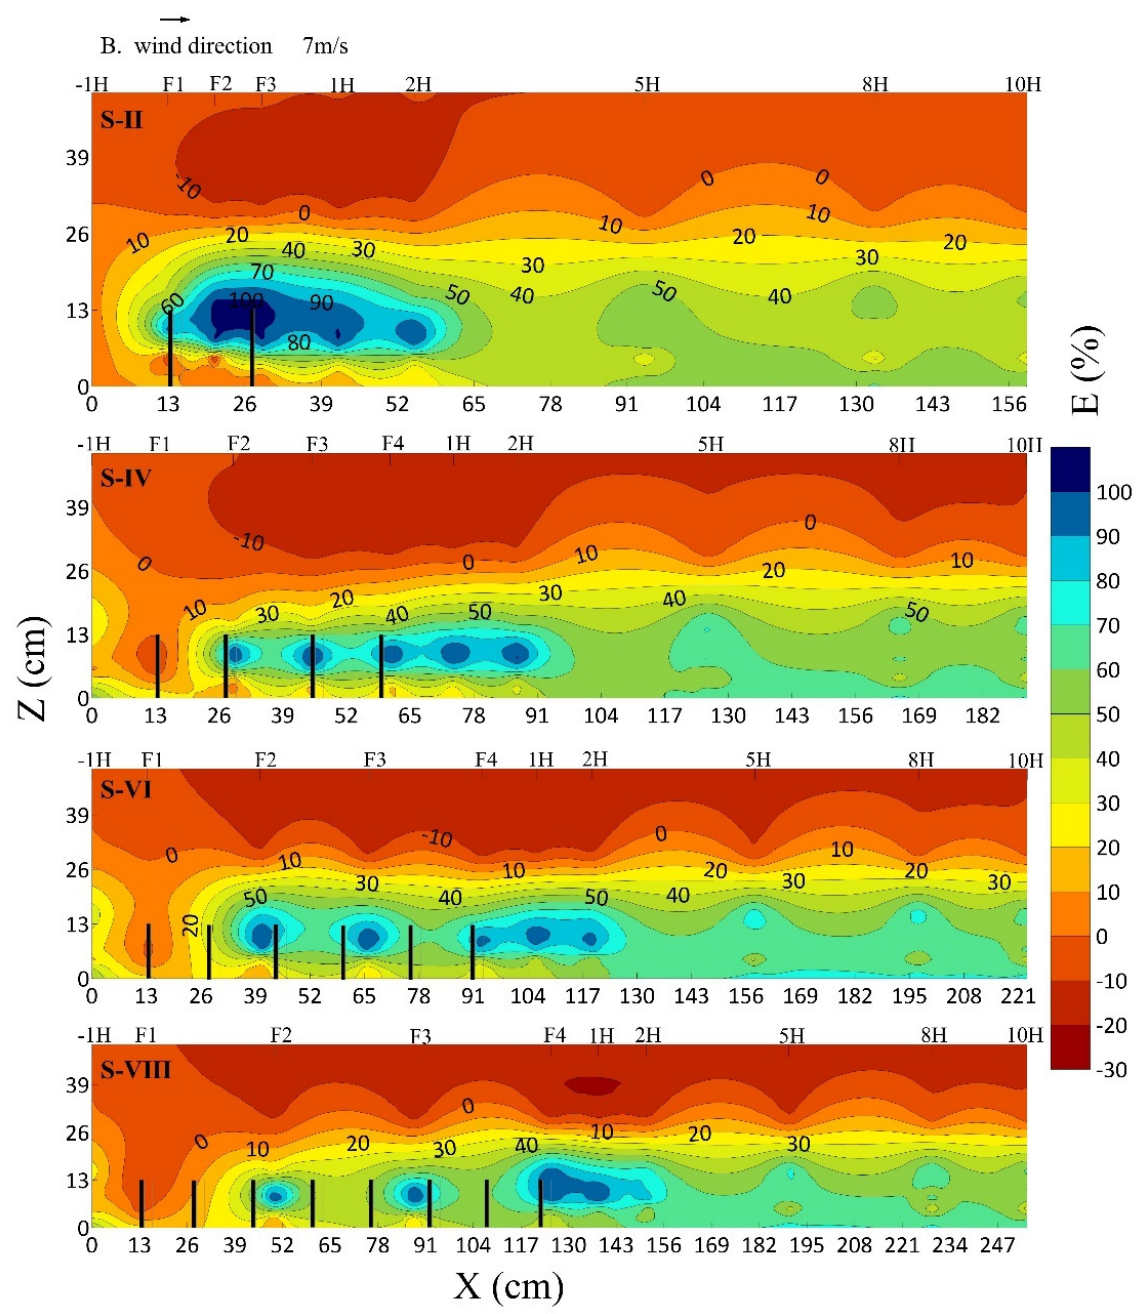
Figure 5. Contour map of the distribution of the shelter efficiency of single shelterbelts with different rows. The abscissa represents the downwind distance (cm) and the ordinate represents the vertical height (cm). The top abscissa represents the observation point. 7 m · s − 1 . The legend indicates the shelter efficiency.